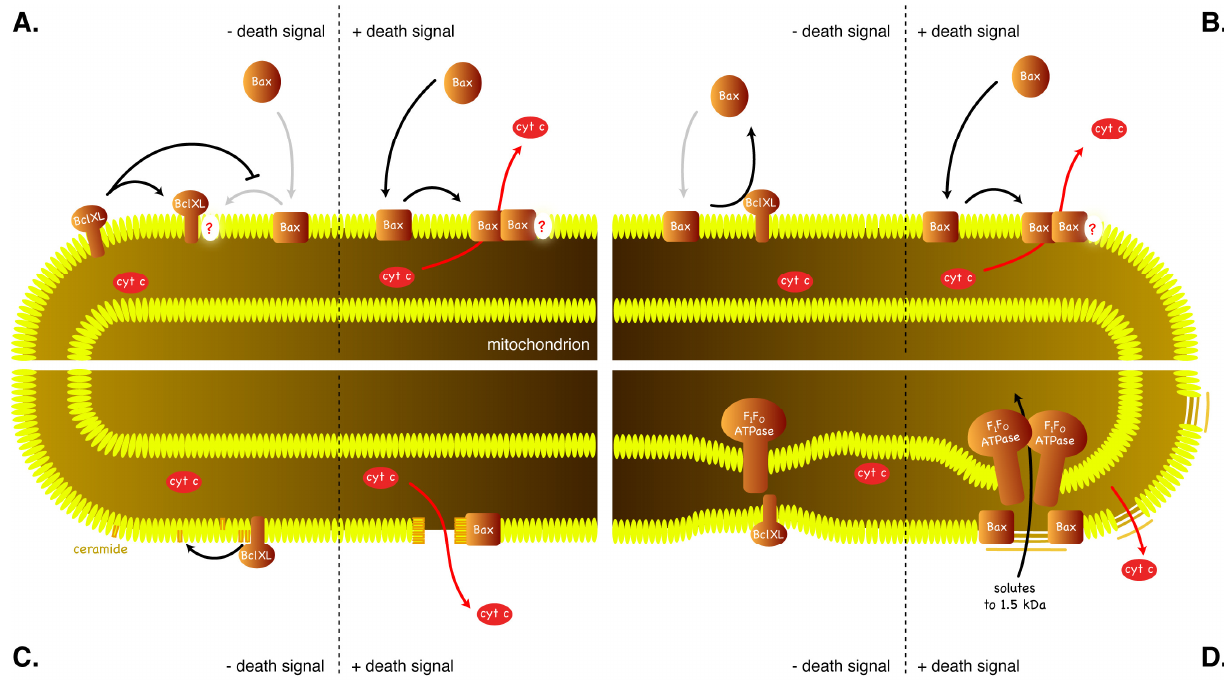
FIGURE 3: Models for inhibition of Bax by antiapoptotic proteins. (A) Competition for a mitochondrial binding site. In order to permeabilize mitochondrial outer membrane, Bax needs to bind to a specific binding site in the membrane. Bcl-XL binds to the same site with higher affin- ity, not allowing Bax to interact with the site. (B) Bax is constitutively targeted into mitochondrial membranes while Bcl-XL retrotranslocates Bax back to the cytosol. (C) Bax induces assembly of ceramide pores in the outer mitochondrial membrane and Bcl-XL disassembles these pores. (D) Bax interacts with F 1 F O -ATPase to induce permeability transition that results in swelling of mitochondria and ultimately the rup- ture of the outer mitochondrial membrane. Bcl-XL inhibits the opening of the permeability transition